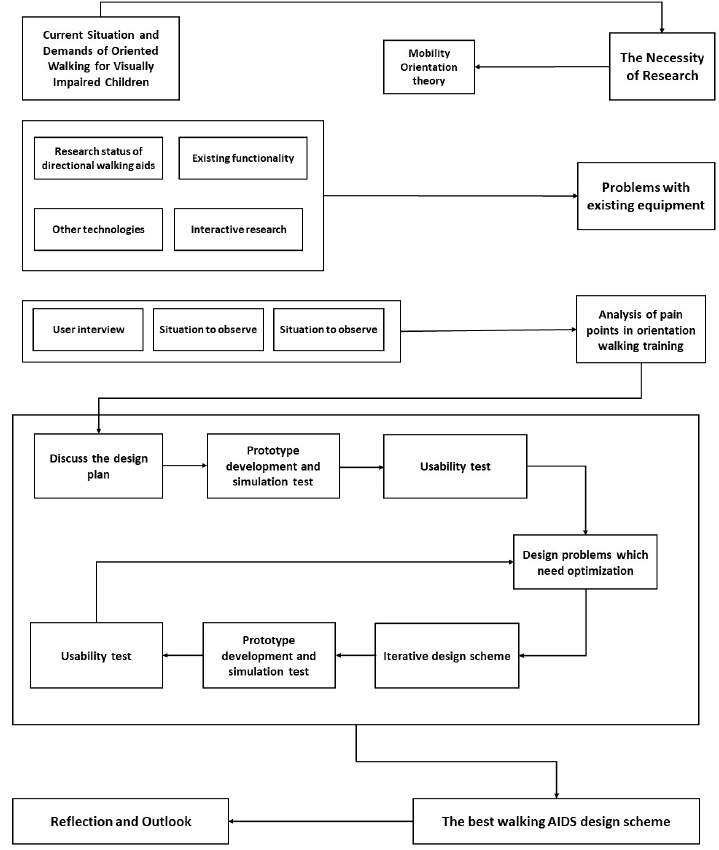
Figure 1. Research Figure 1. Research framework.